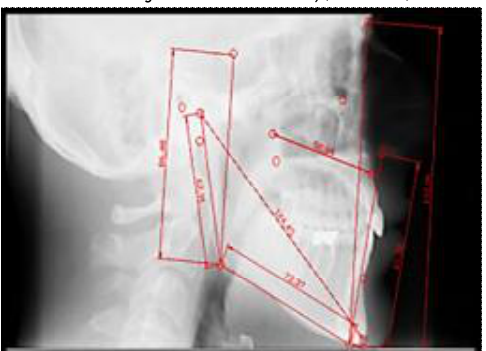
Figure 2: Linear Measurements Obtained from Cephalometric